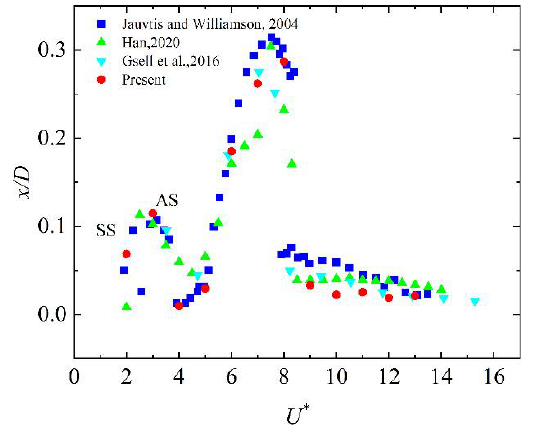
Figure 6. Variation of streamwise amplitude with reduced velocity [22,24,25].